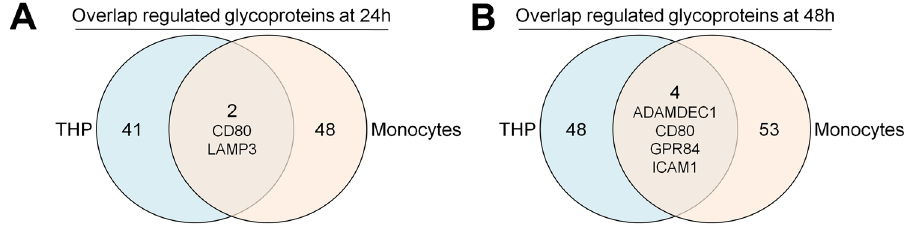
Figure 4. Comparison of differently expressed glycoproteins identified in CD14 + monocytes and THP-1 cells. (A + B) Venn diagrams showing the overlap between differently expressed glycoproteins identified in monocytes and THP-1 cell at 24 h ( A ) and 48 h ( B ) of LPS